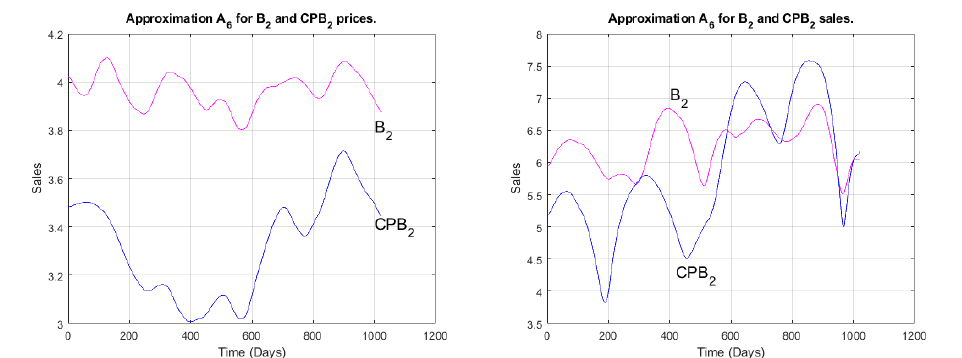
Figure 14. The wavelet approximations A 6 for B 2 and CPB 2 prices and sales at level